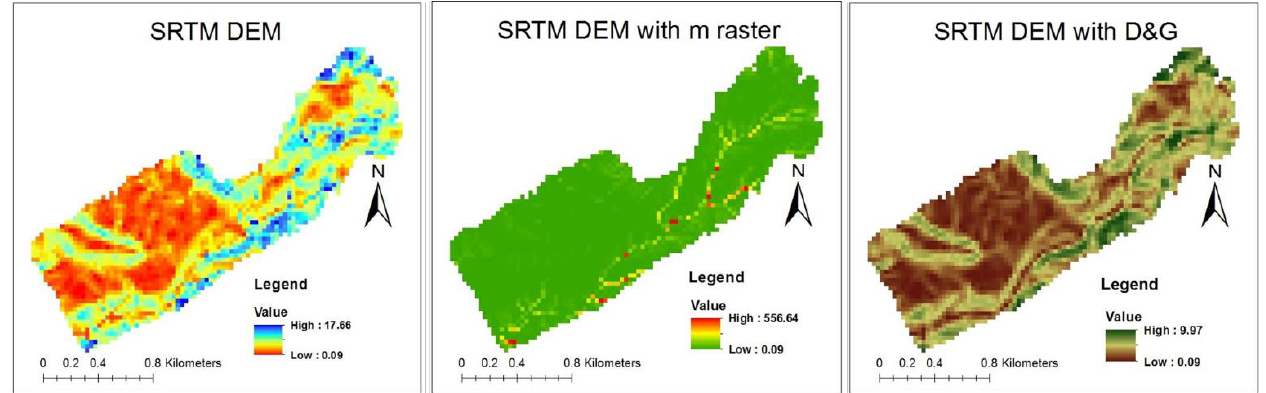
Figure 7: LS factor of SRTM DEM with constant slope exponent, spatially distributed slope exponent and with multiple flow